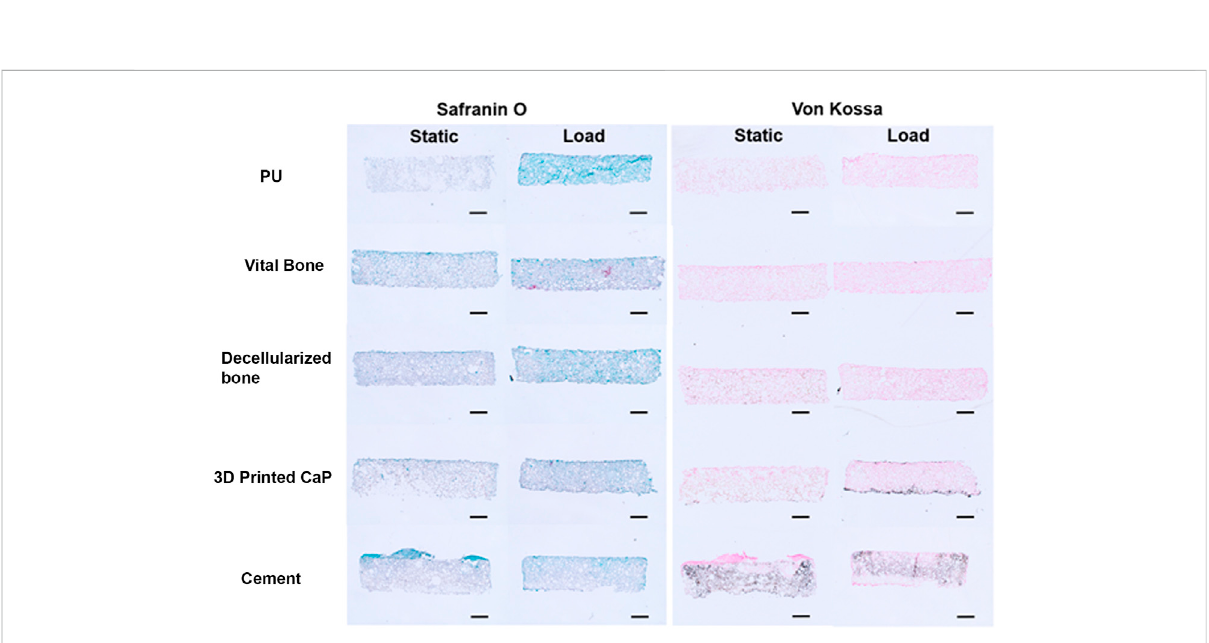
FIGURE 7 ExampleSafraninOandVonKossahistologyafter28 daysofculture.SafraninOstainingwasminorduetothehighresaleofproducedGAGinto the culture medium. Von Kossa staining was observed at the interface (3D Printed CaP) or throughout (cement) the upper MSC laden scaffold. This was not observed when PU or bone was used as the base. (Scale bar = 1